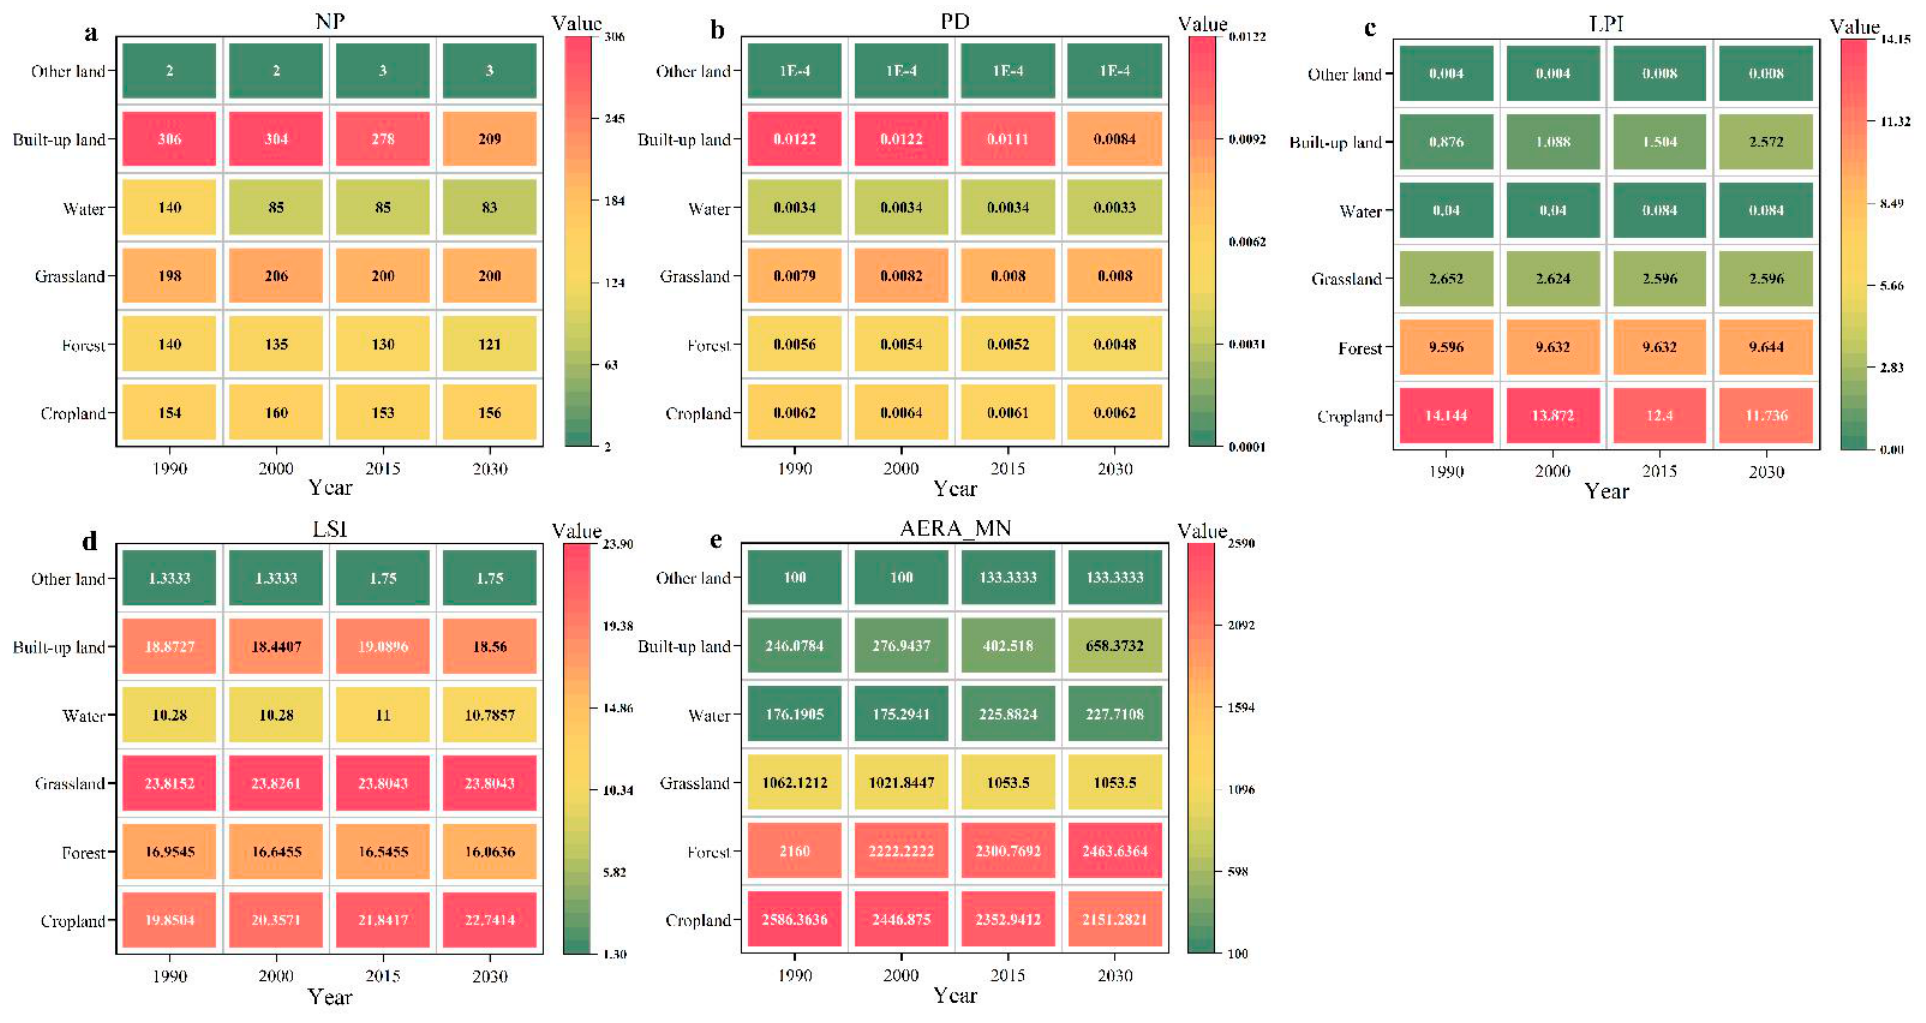
Figure 10. Changes in the land use pattern for the different land use types.